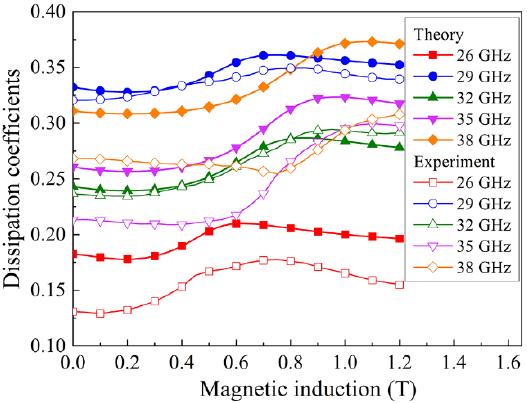
Figure 8. Dependences of microwave dissipation on the magnetic field for several millimeter-wave frequencies for a composite with 3.8% flakes and 2% CNT.